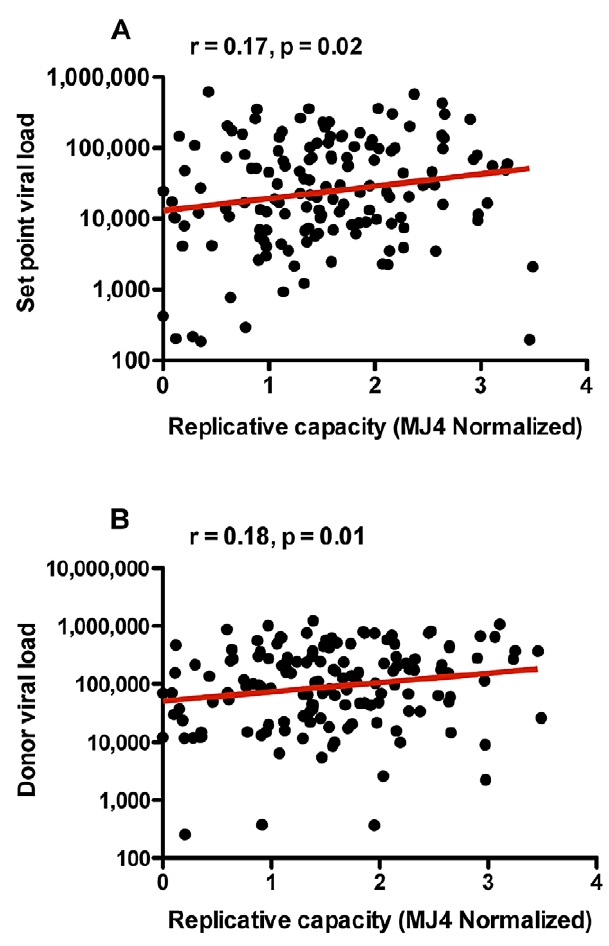
Figure 2. Replicative capacity is correlated to viral load in recipients and donors. (A) The RC of Gag-MJ4 chimeras generated from gag sequences isolated from epidemiologically linked recipients at acute time points correlates to early set point VL in the same acutely infected recipients (Spearman correlation, r=0.17, p=0.02). Replicative capacity scores were generated by normalizing the log 10 -transformed slopes of replication curves from days 2 through 6 for each Gag-MJ4 chimeric virus to the log 10 -transformed slope of wild-type MJ4. (B) The RC of Gag-MJ4 chimeric viruses also correlates to the VL near the estimated date of infection in chronically infected donors (Spearman correlation, r=0.18, p=0.01). Trend lines were generated using linear regression analysis, and are shown in order to facilitate visualization of correlations.